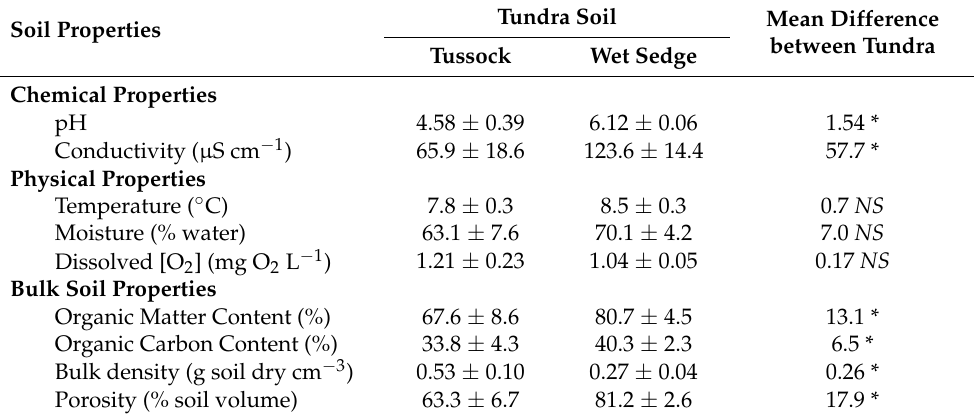
Table 1. The chemical and physical soil properties in tussock tundra and wet sedge tundra mesocosms in the biotic response cores were measured at the end of the anoxic acclimation period (T0), and bulk soil properties were measured at the end of the experiment (mean ± SD; N = 3 per tundra ecosystem). Asterisks indicate significant differences in mean pairwise similarity between tussock and wet sedge